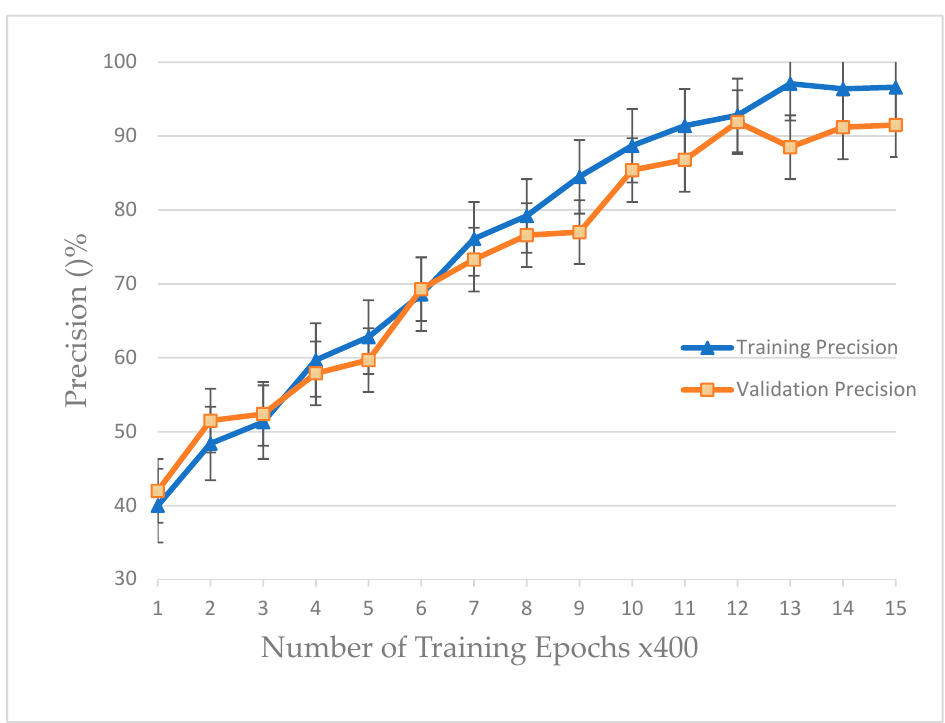
Figure 7. Training and validation precision change with the number of training epochs.